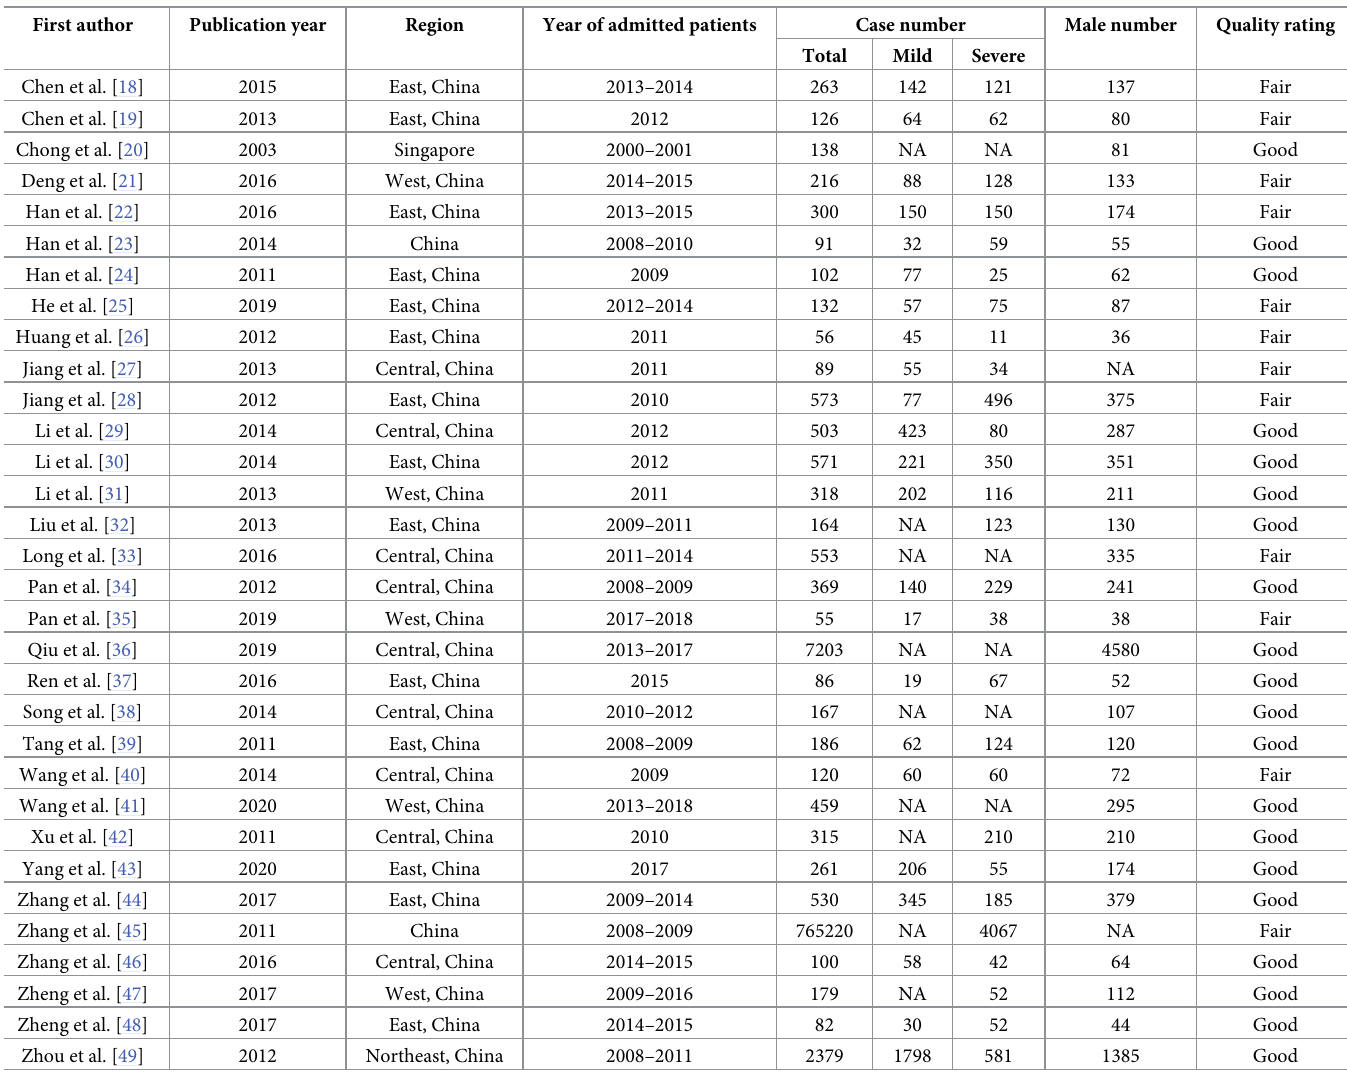
Table 1. The basic characteristics of studies in